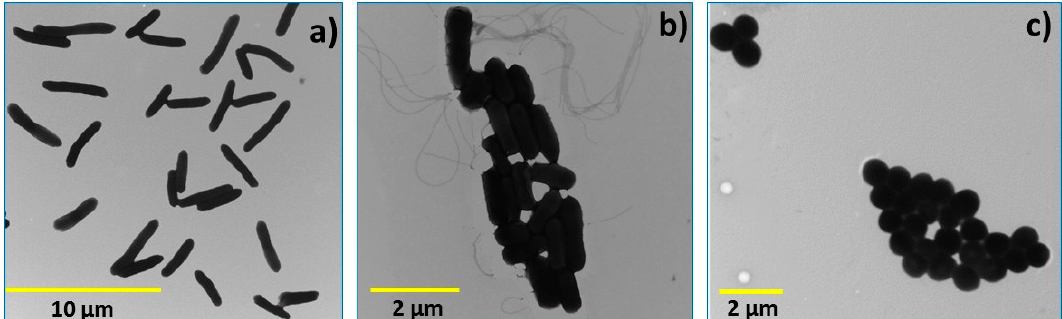
Figure 10. Morphology of intact: ( a ) E. coli ; ( b ) L. innocua ; ( c ) S. aureus cells . Images were kindly provided by Mounia Arkoun from the Chemical Engineering Department, Polytechnique Montréal.